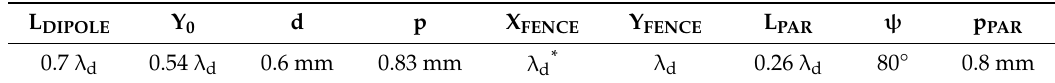
Table 1. Electric dipole design parameters.